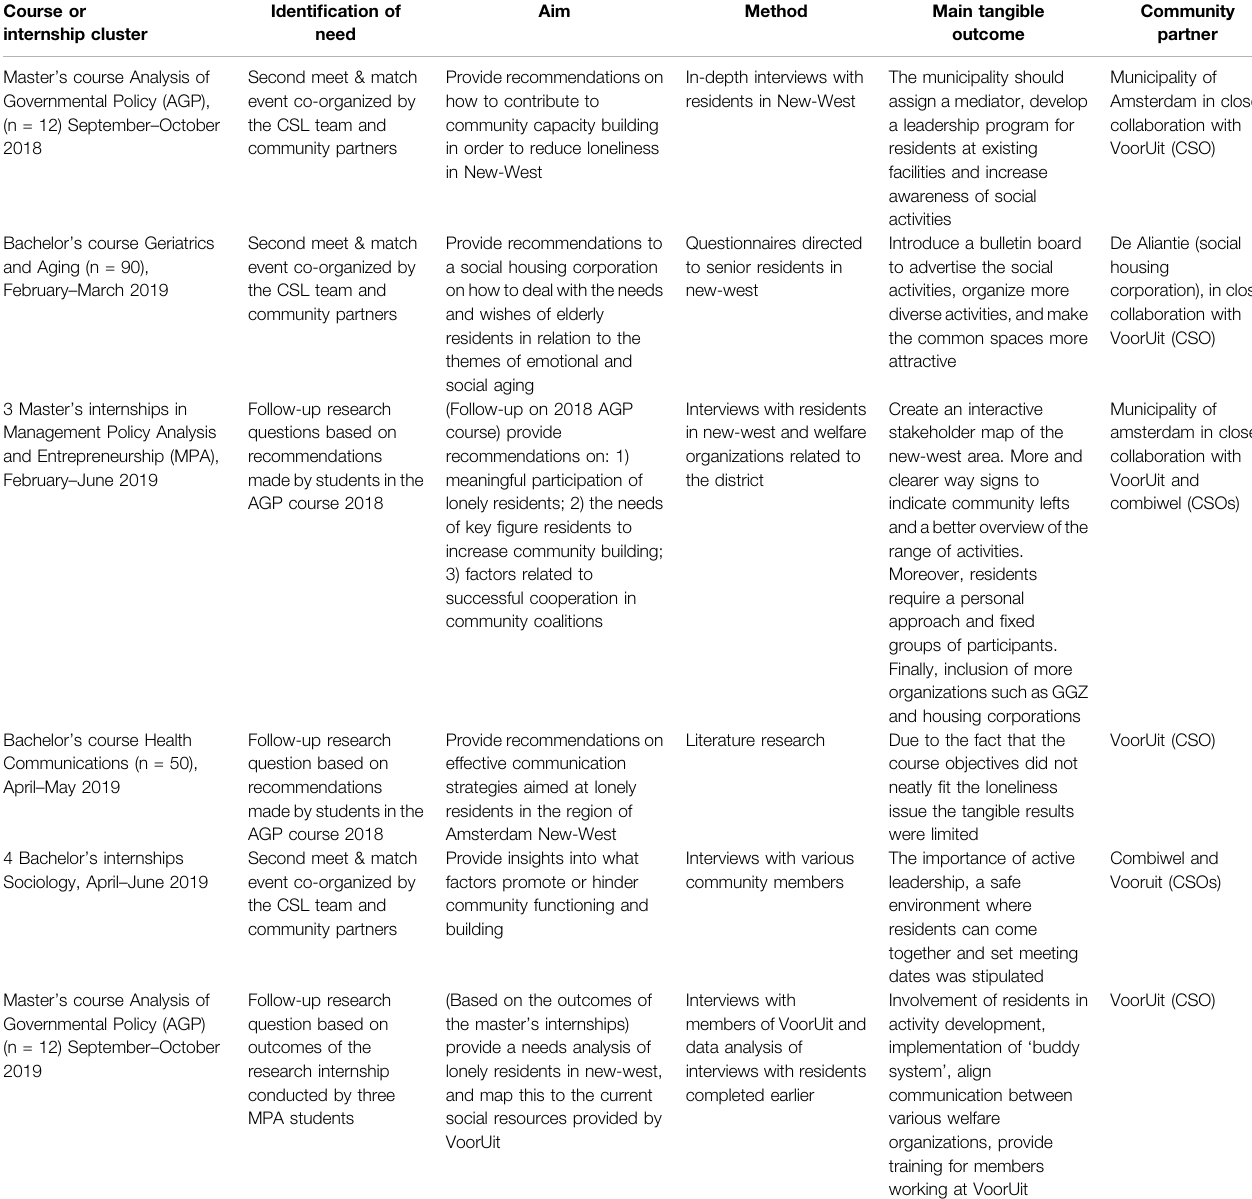
TABLE 2 | An overview of the main tangible outcomes by student